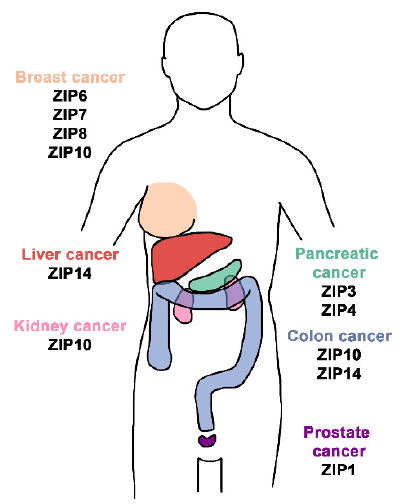
Figure 9. A Schematic showing the association of the members of the LIV-1 Zn-ZIP transporter family and the different cancers that have been implicated these transporters. Redrawn from an imge in Reference [168].